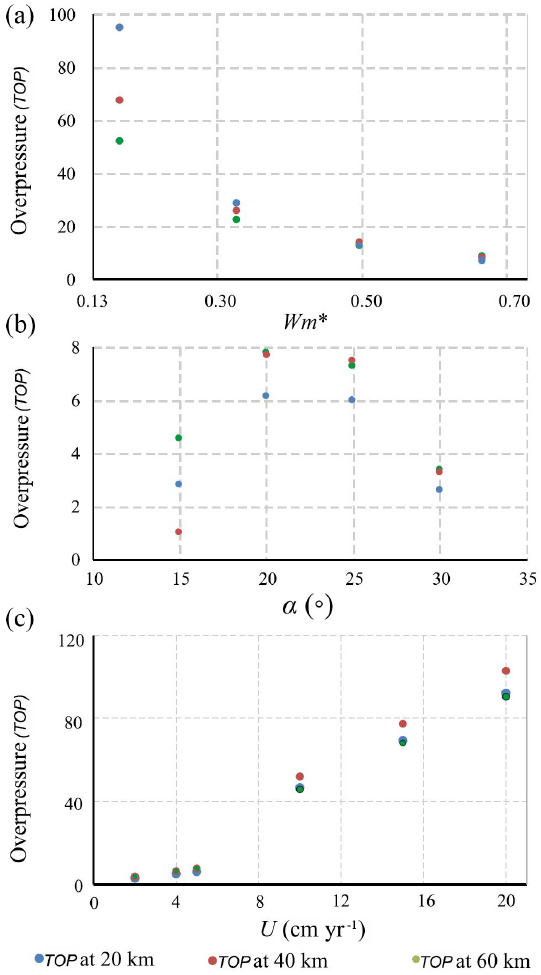
Figure 4. Graphs showing overpressure factor TOP as a function of normalized channel mouth width W ∗ m (a) , channel dip α (b) , and convergence velocity U (c) , for a viscosity η = 10 22 Pas. For each tested variable, other values are kept constant: W ∗ m = 100 / 150 = 0 . 67 (except in a ), α = 20 ◦ (except in b ), U = 5cmyr − 1 (except in c ). Comparison with Fig. 3 shows that η = 10 22 Pas induces much higher overpressure, especially at smaller W ∗ m and higher U .